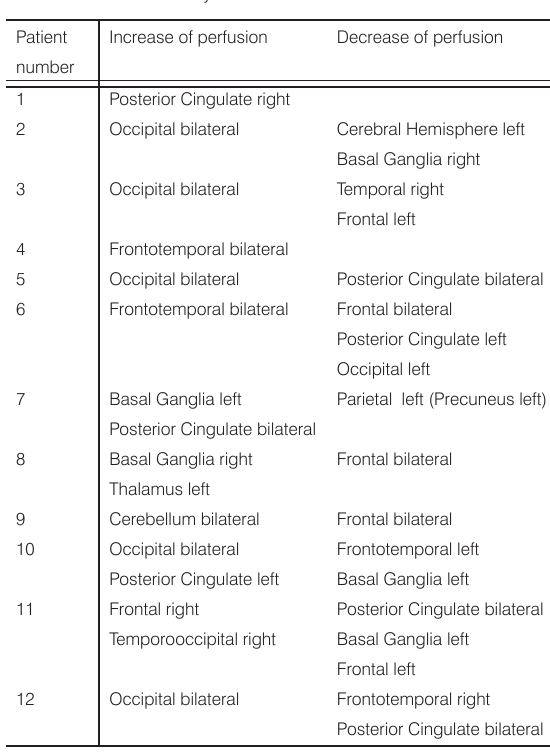
Table 3. Localization of perfusion changes after activation in voxel- based